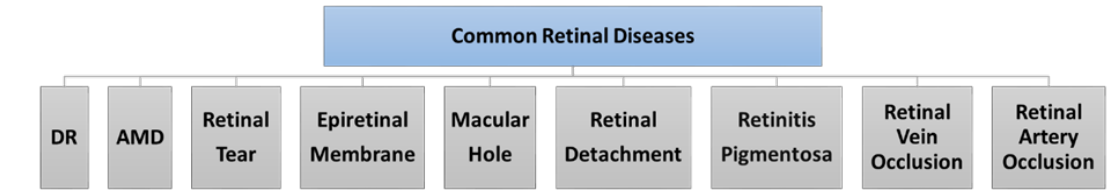
Figure 1. Common retinal diseases.